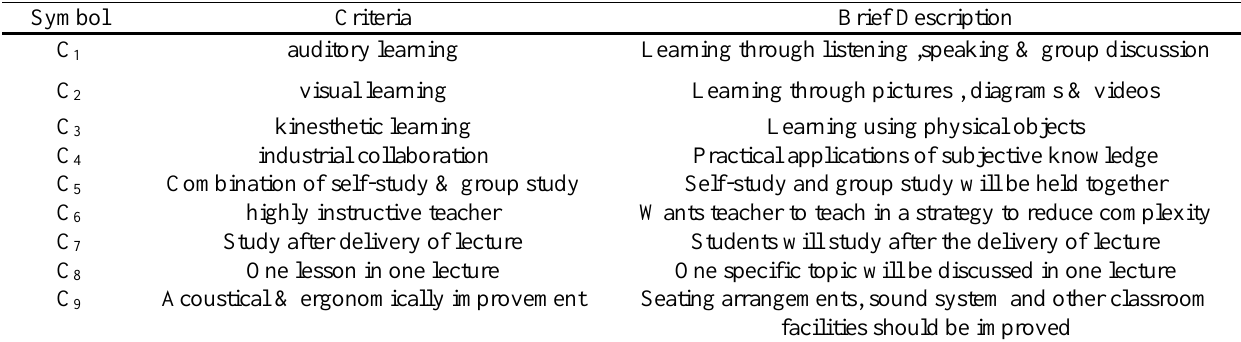
Table 3. Criteria for teaching method